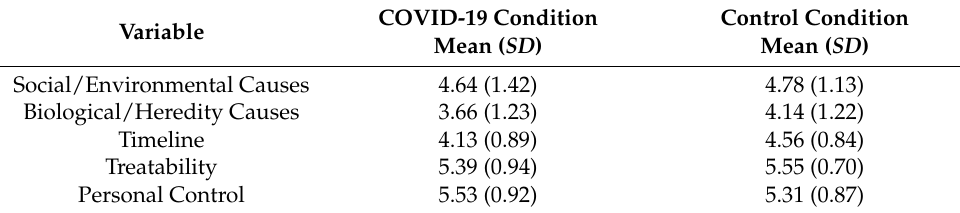
Table 1. Descriptive statistics across experimental conditions in Study